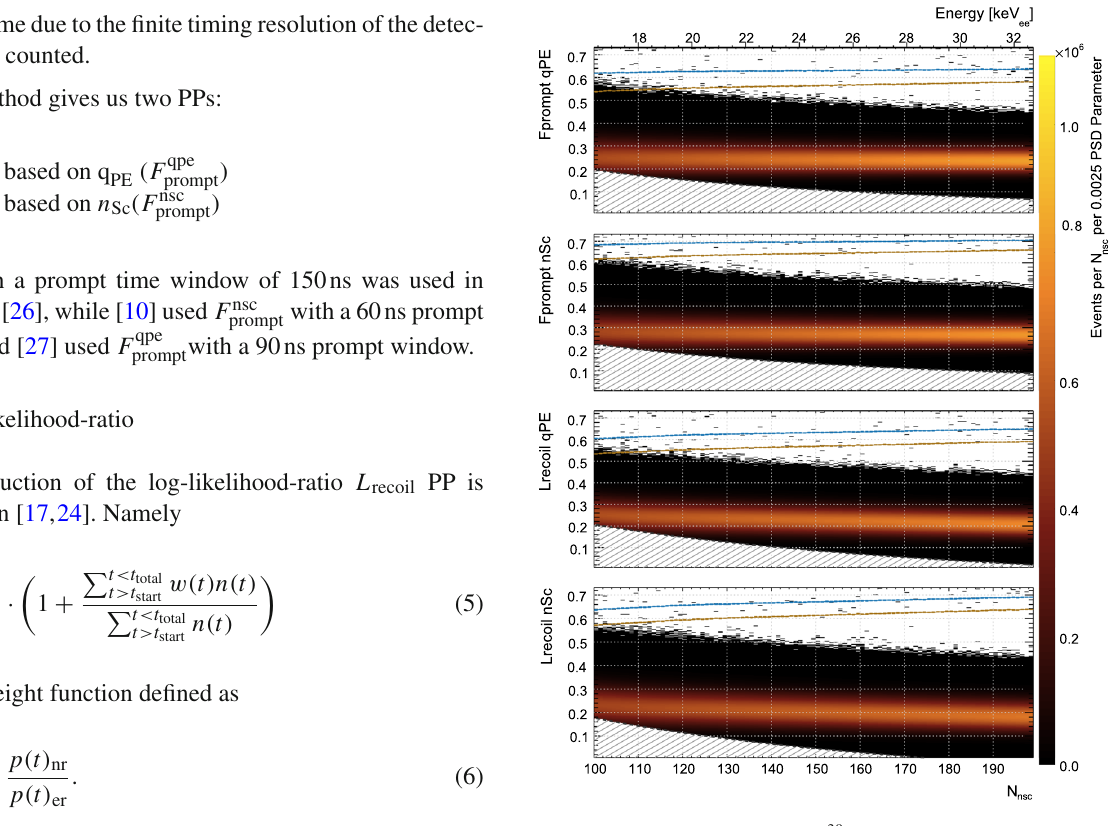
Fig. 1 The distributions of mainly 39 Ar β decay events for each of the four PSD parameters as a function of energy. The 50% (blue) and 90% (brown) nuclear recoil acceptance lines are also shown. Some events are expected above the 39 Ar population because only a subset of the WIMP analysis cuts are